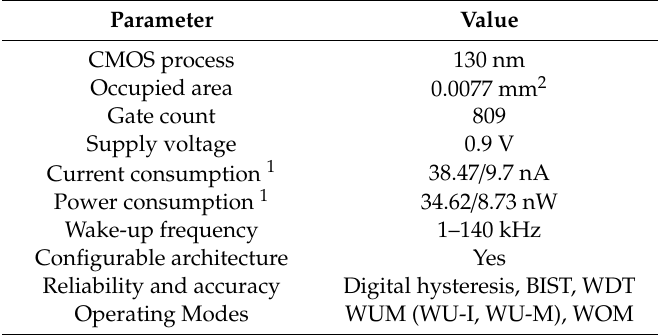
Table 1. IDC performance summary.